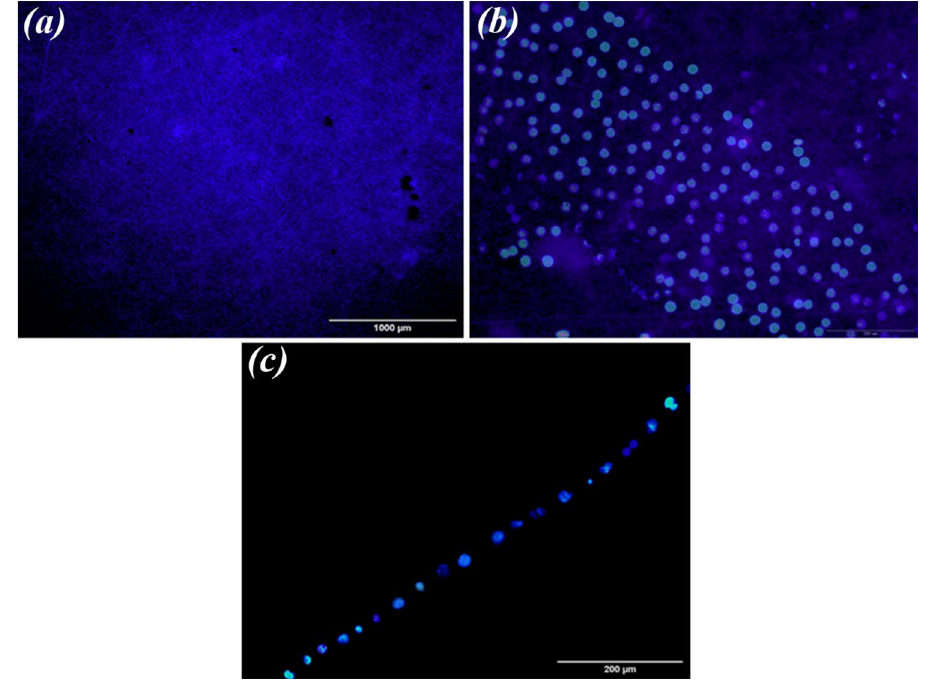
Figure 16. ( a , b ) Immunofluorescence images of nuclei (DAPI) in ARPE cells seeded on PCL-30HAMP scaffolds for 7 days. ( c ) Cross-sectional visualization of a monolayer of ARPE cells on PCL-30HAMP scaffolds with nuclei staining (DAPI) after 7